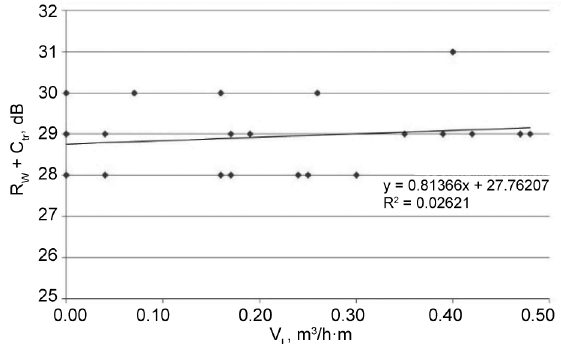
Figure 11. Relationship between weighted sound reduction index with spectrum adaptation term of transport and air